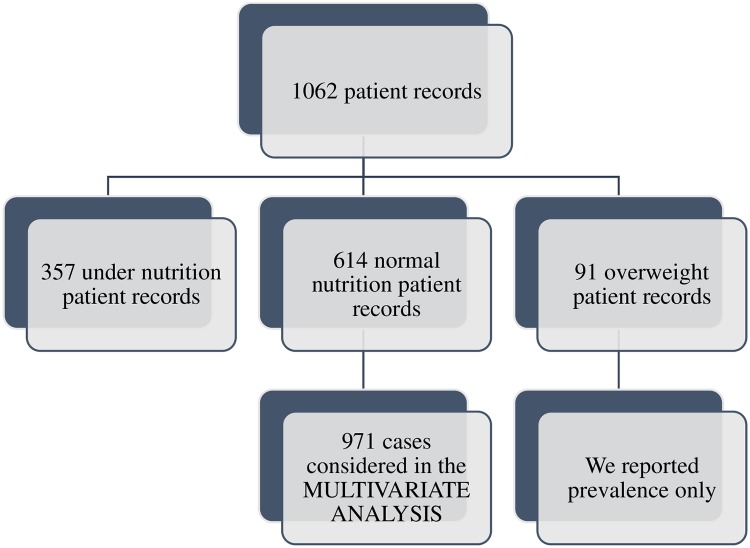
Study flow diagram.